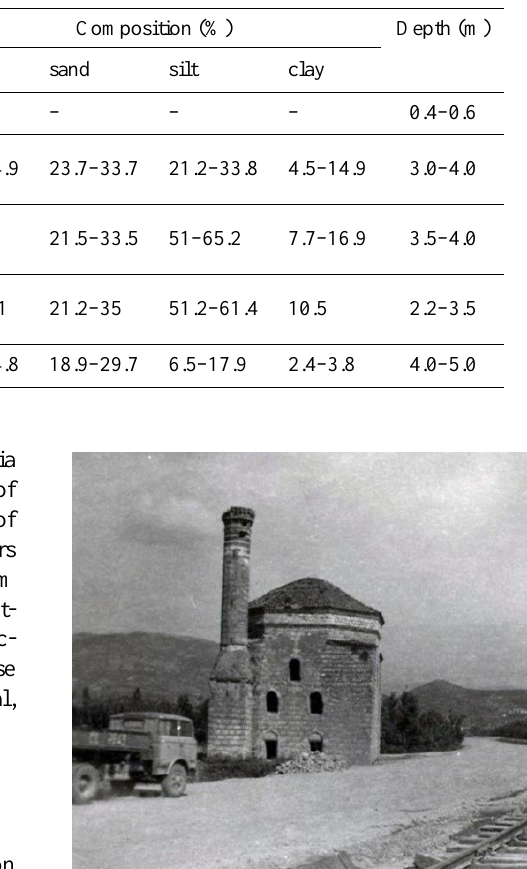
Table 1. Geological properties of soil under the structure.